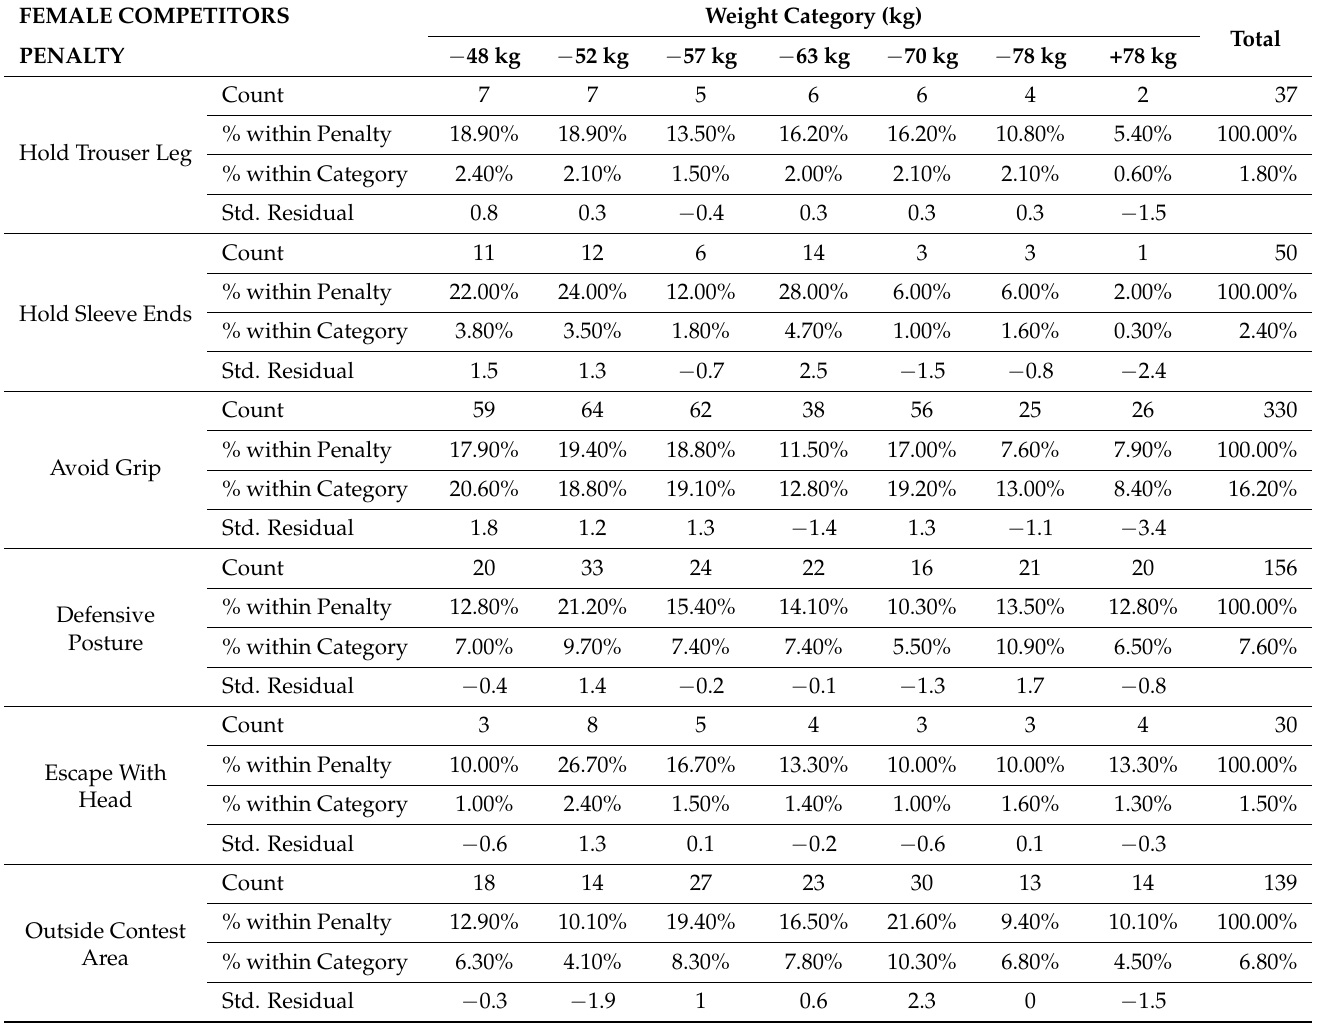
Table 1. Frequencies, percentage values and standardised residuals of individual penalties in all weight categories for female